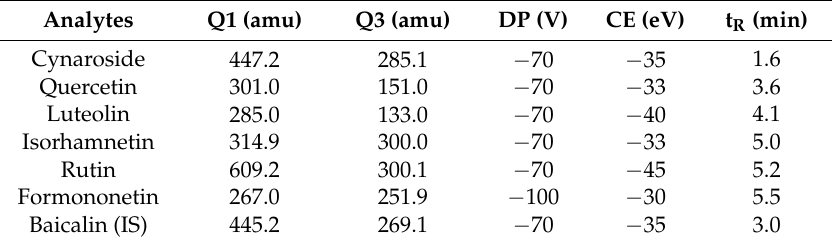
Table 5. Optimized multiple-reaction-monitoring (MRM) parameters for cynaroside, quercetin, luteolin, isorhamnetin, rutin, formononetin and baicalin (IS). Analytes Q1 (amu) Q3 (amu) DP (V) CE (eV) t R (min) Cynaroside 447.2 285.1 − 70 − 35 1.6 Quercetin 301.0 151.0 − 70 − 33 Luteolin 285.0 133.0 Isorhamnetin Rutin Formononetin 267.0 251.9 Baicalin (IS) 445.2